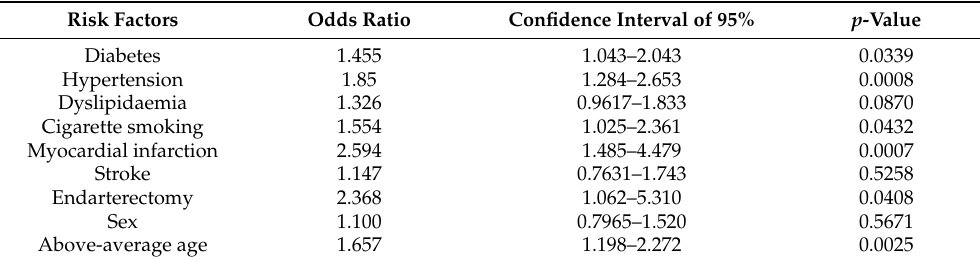
Table 3. Analysis of the correlations between the risk factors and worsening of carotid stenosis (stable vs. worsened